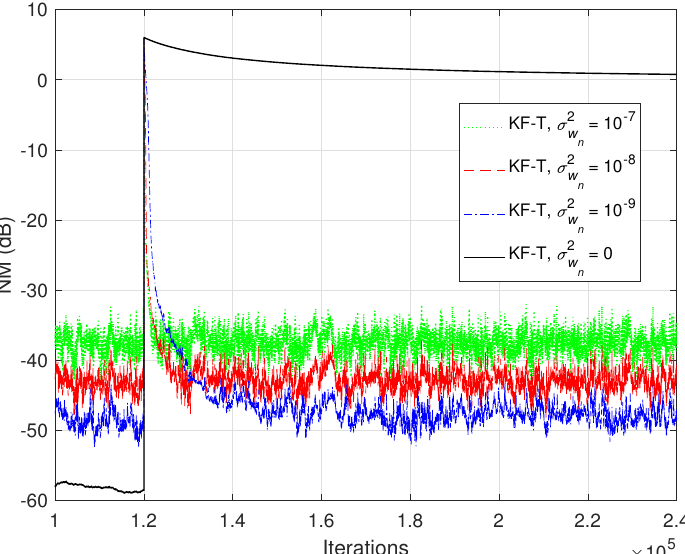
Figure 3. Normalized misalignment (NM) of the KF-T using different values of σ 2 w for the identification of the global impulse response, h ( t ) . The first individual impulse response changes from h 1 ( t ) to − h 1 ( t ) in the middle of